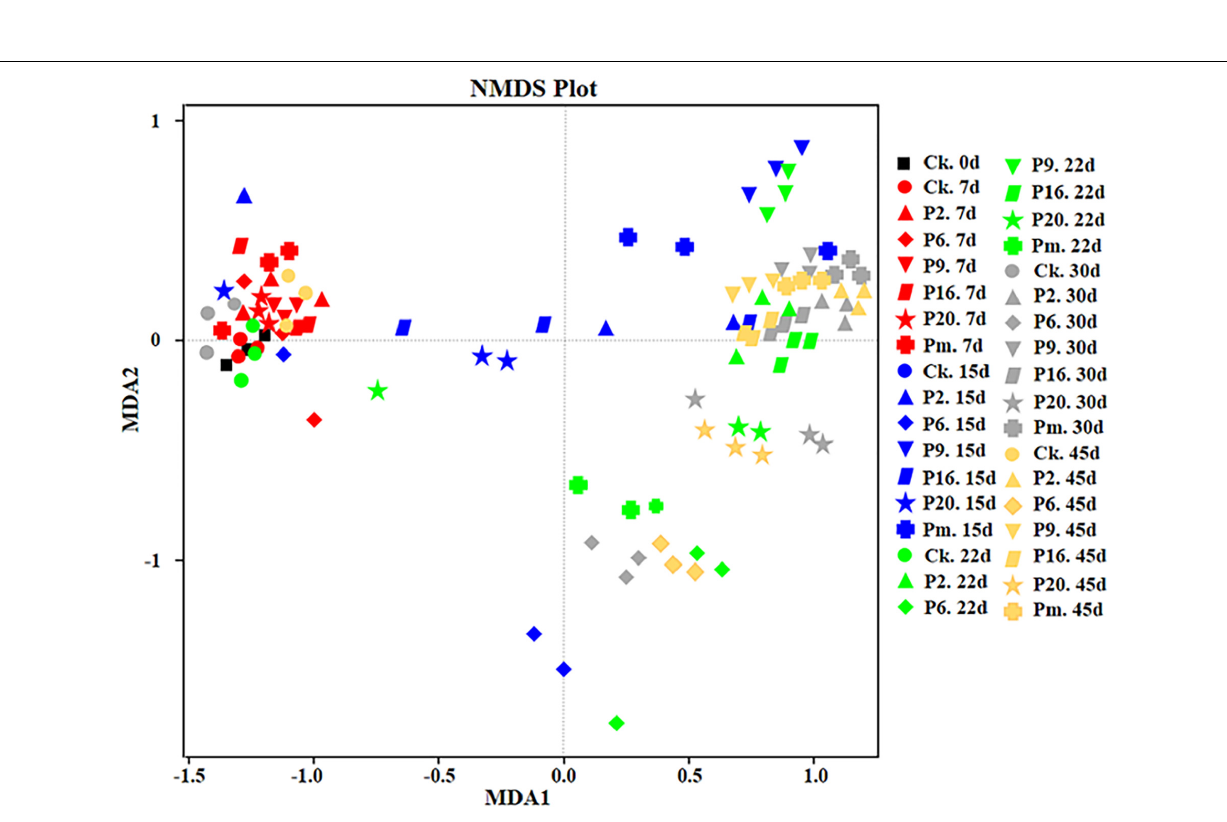
Frontiers in Microbiology |